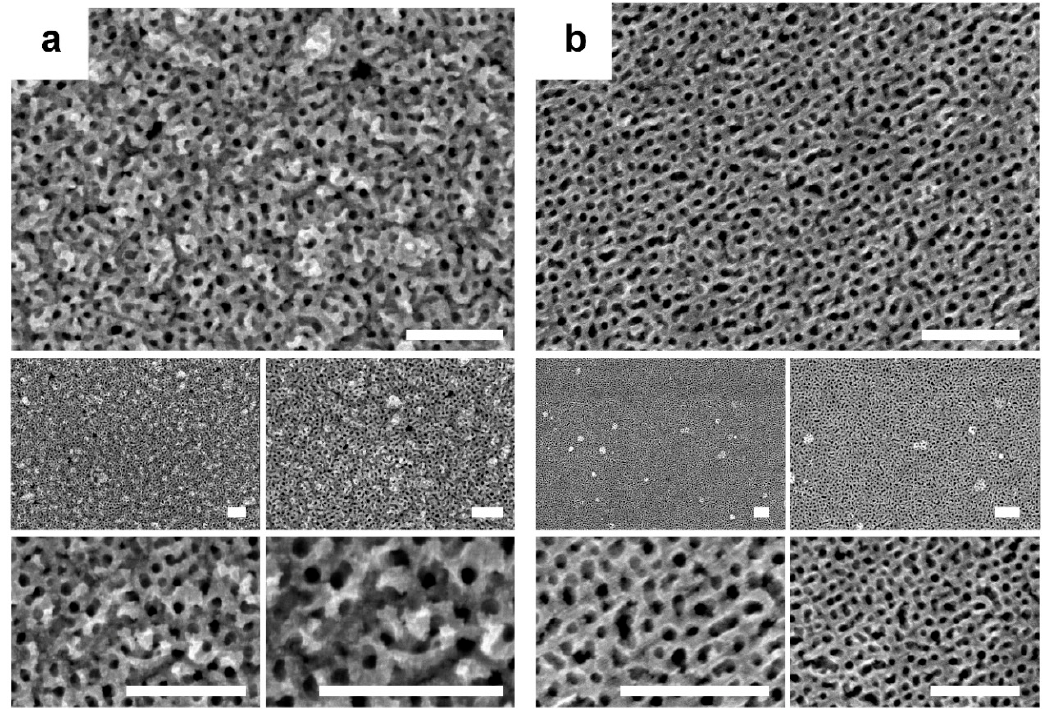
Figure 5. FE-SEM micrographs at different magnifications of the deposits obtained using Ni-Pt (Bath 4) solution on ( a ) FTO-coated glass and ( b ) Si/Ti/Au substrates at − 1.3 V (vs. Ag|AgCl) after circulating 7.5 C cm − 2 . Scale bar: 300 nm. Table 2. Deposition potential, average thickness, elemental composition, pore diameter, and BET surface area of the Ni-rich Ni-Pt mesoporous films.